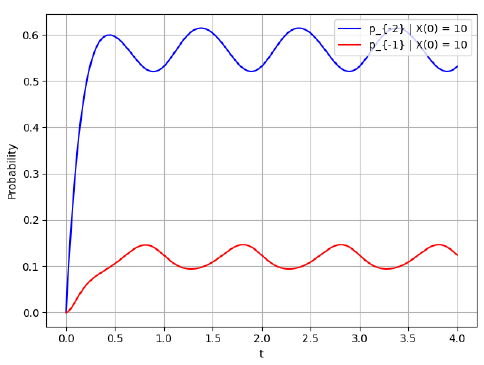
Figure 6. Probability F , R for t ∈ [ 0,4 ] ; this figure shows the rate of convergence.